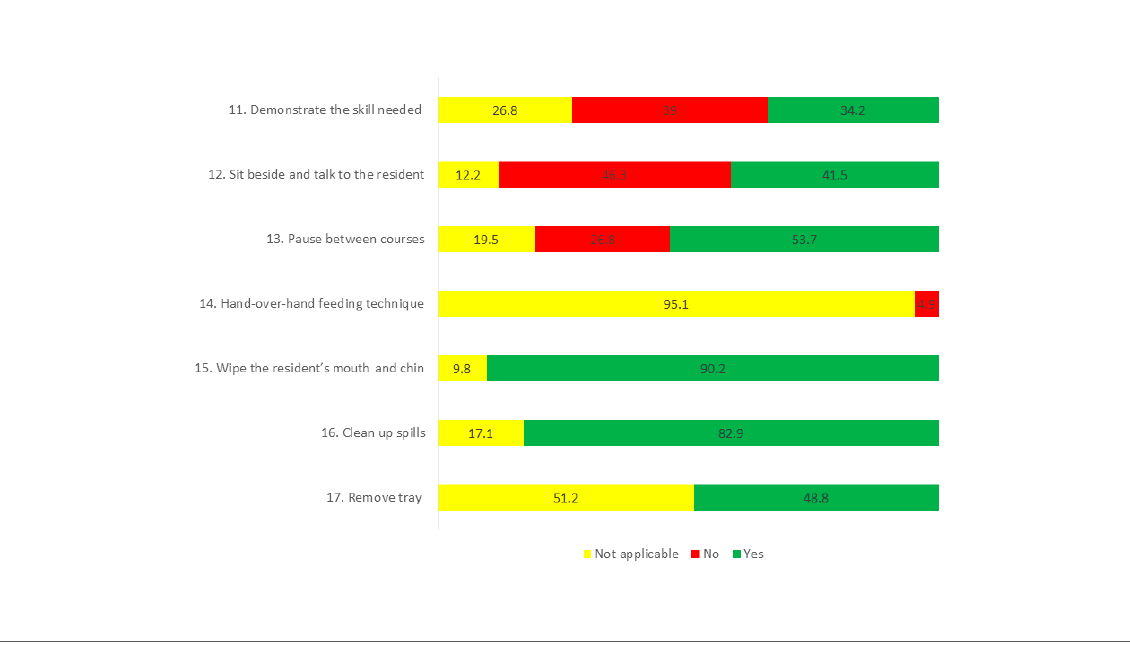
Figure 2. Actions performed (%)—Caregiver dimension.